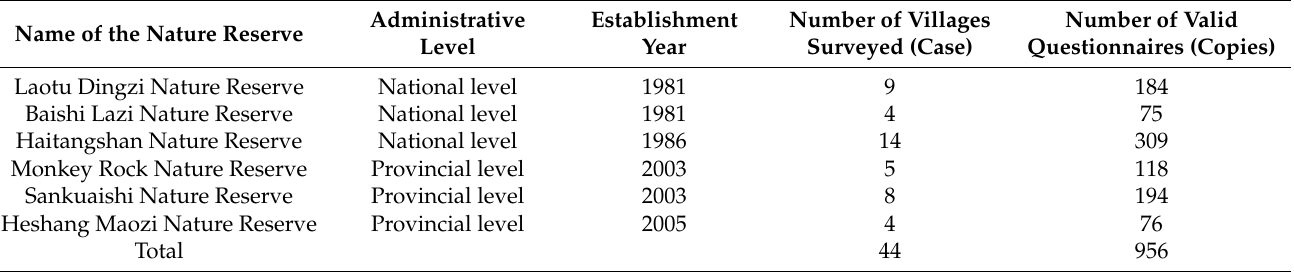
Table 1. Administrative levels and establishment times of the 6 nature reserves in Liaoning province and the numbers of valid